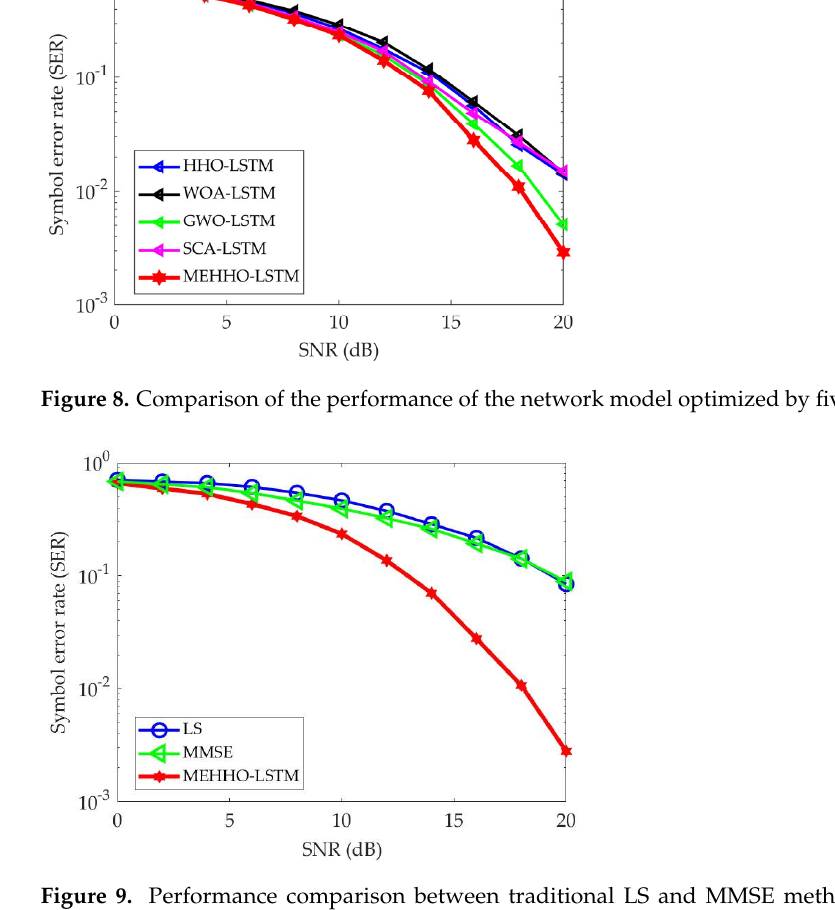
Figure 9. Performance comparison between traditional LS and MMSE methods and MEHHO ‐ LSTM methods.